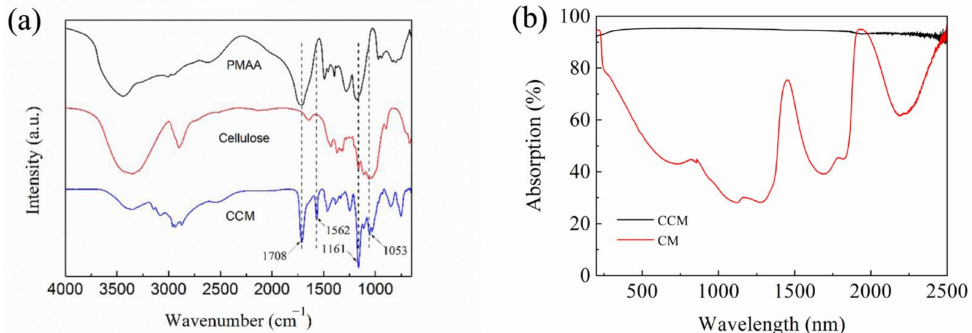
Figure 5. ( a ) FTIR spectra of the cellulose, PMAA and CCM; ( b ) UV-vis-NIR spectra of CM and